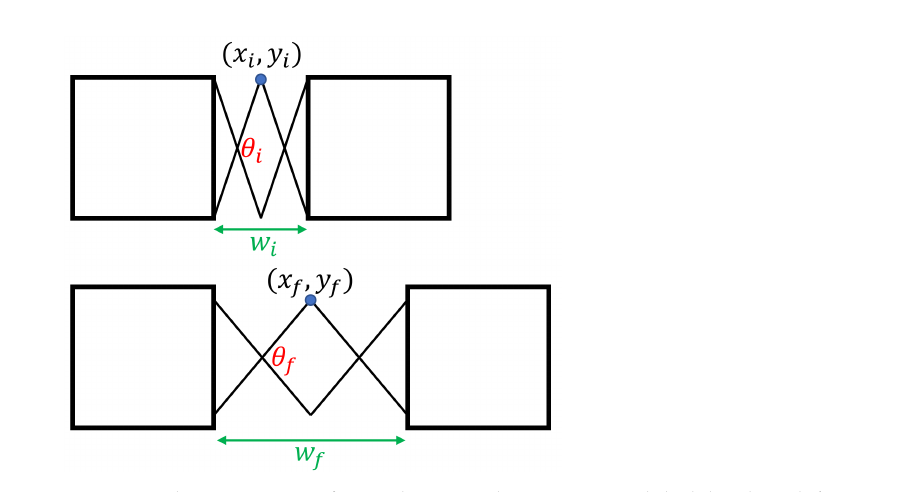
Figure 8. The movement of a single scissor-hinge unit. Each link has length l . The above may now be extended to determine the movement of an entire mechanism during its deployment, as shown in Figure 9.